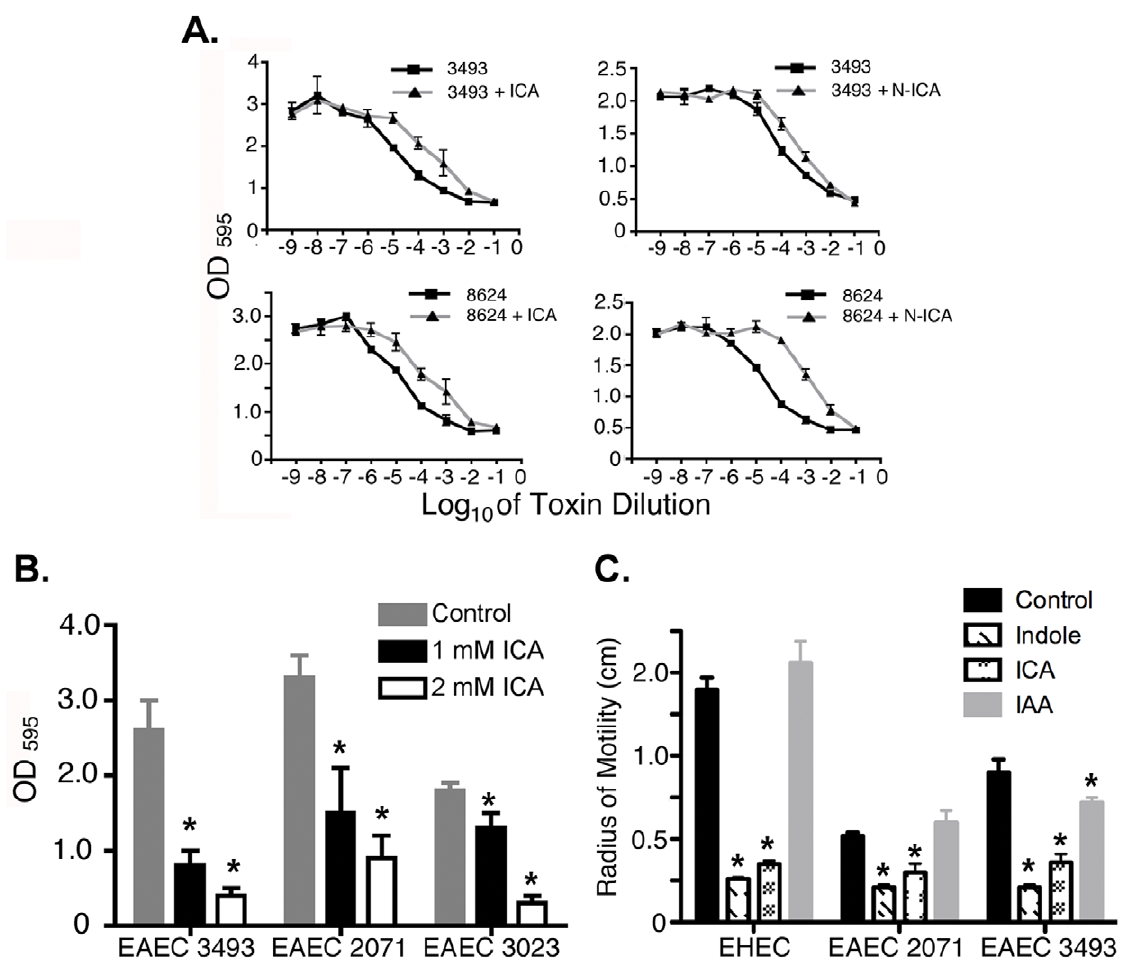
Figure 6. Indole derivatives inhibit Shiga toxin production, biofilm and motility in EHEC and EAEC. ( a ) Effects of ICA or the synthetic analog 4-nitroindole-3-carboxaldehyde (N-ICA) on Shiga toxin production by EHEC 8624 or EAEC 3493. Cytotoxic effect on vero cells was used as a measure of Shiga toxin production. ( b ) Effects of ICA on biofilm in EAEC 3493, EAEC 2071, and EHEC 3023. ( c ) Effects of Indole, ICA, and IAA on motility in soft agar of EAEC 3493, EAEC 2071, and EHEC O157:H7 EDL933. For b-c, mean + / 2 SEM are shown; * corresponds to p , 0.01 with respect to untreated control.